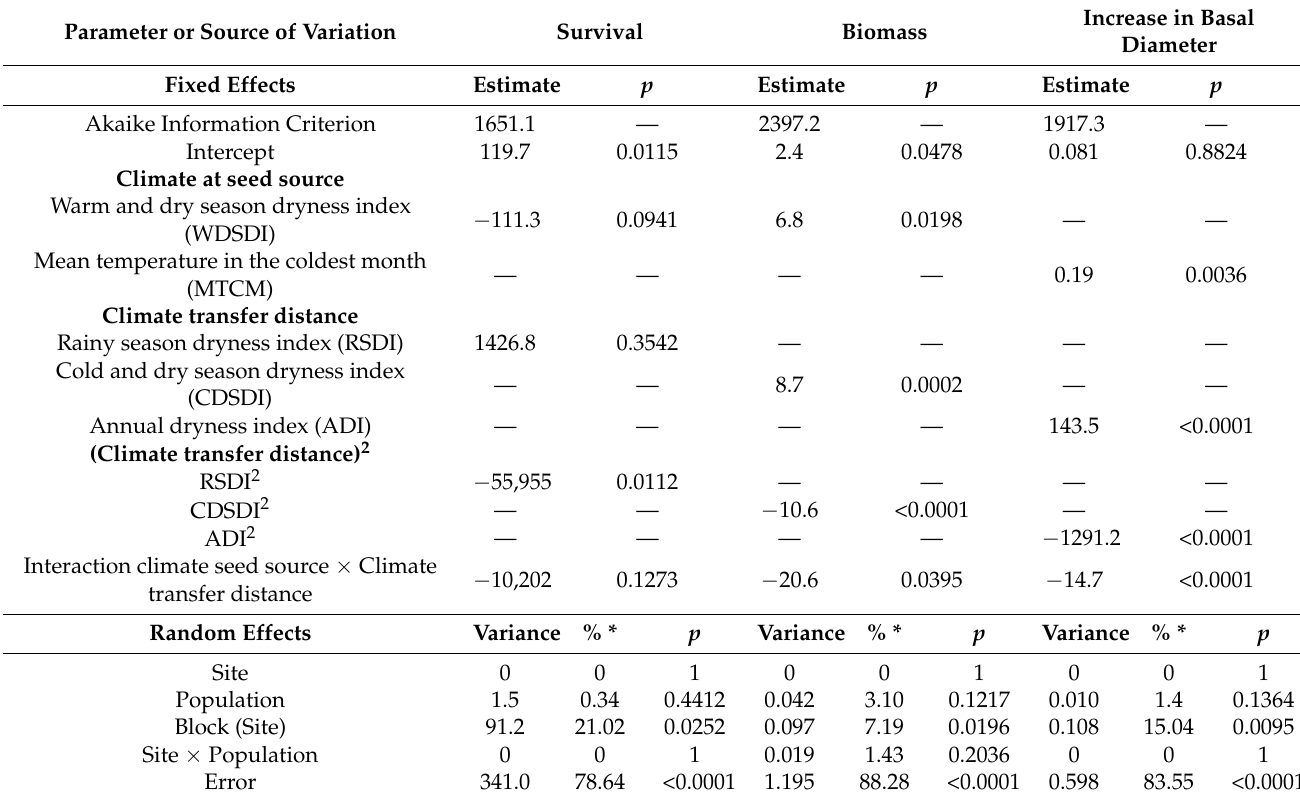
Table 4. Analysis of the mixed model for seedling survival, biomass and increase in basal diameter. Akaike information criterion (AIC), estimated parameters (coefficients of regression for fixed effects and variances estimated for random effects), contribution to the total variance (of the random effects) and significance ( p